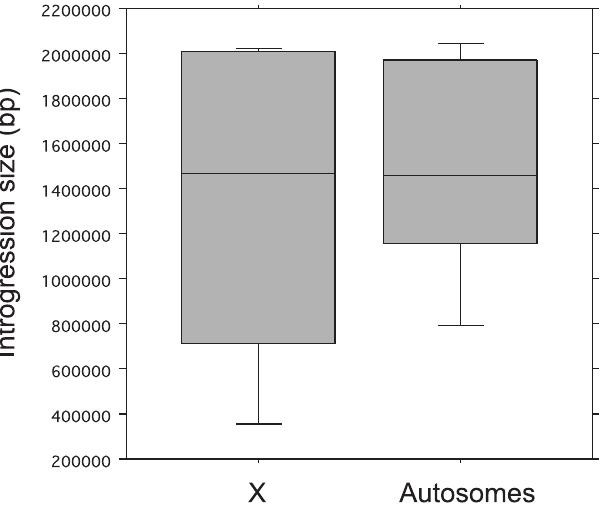
Figure 3. Distribution of X Chromosomal and Autosomal Introgression Sizes Boxes show the interquartile range; vertical lines are drawn out to the extreme values; horizontal lines within boxes show the median.